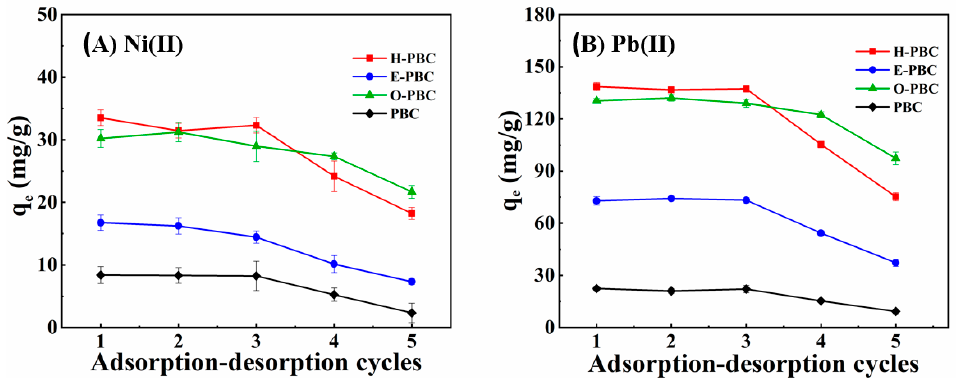
Figure 5. Recyclability analysis for the adsorption of ( A ) Ni(II) and ( B ) Pb(II) by PBC, H-PBC, E-PBC, and O-PBC. Experimental conditions: adsorbent dosage = 200 mg; [Ni(II)] and [Pb(II)] = 40 mg/L; adsorption time = 9 h.